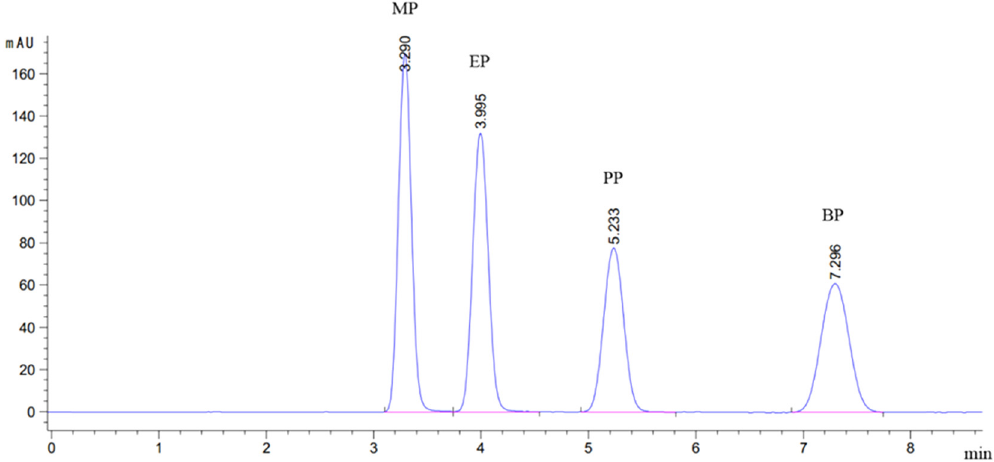
Figure 7: Chromatograms of the mixed reference